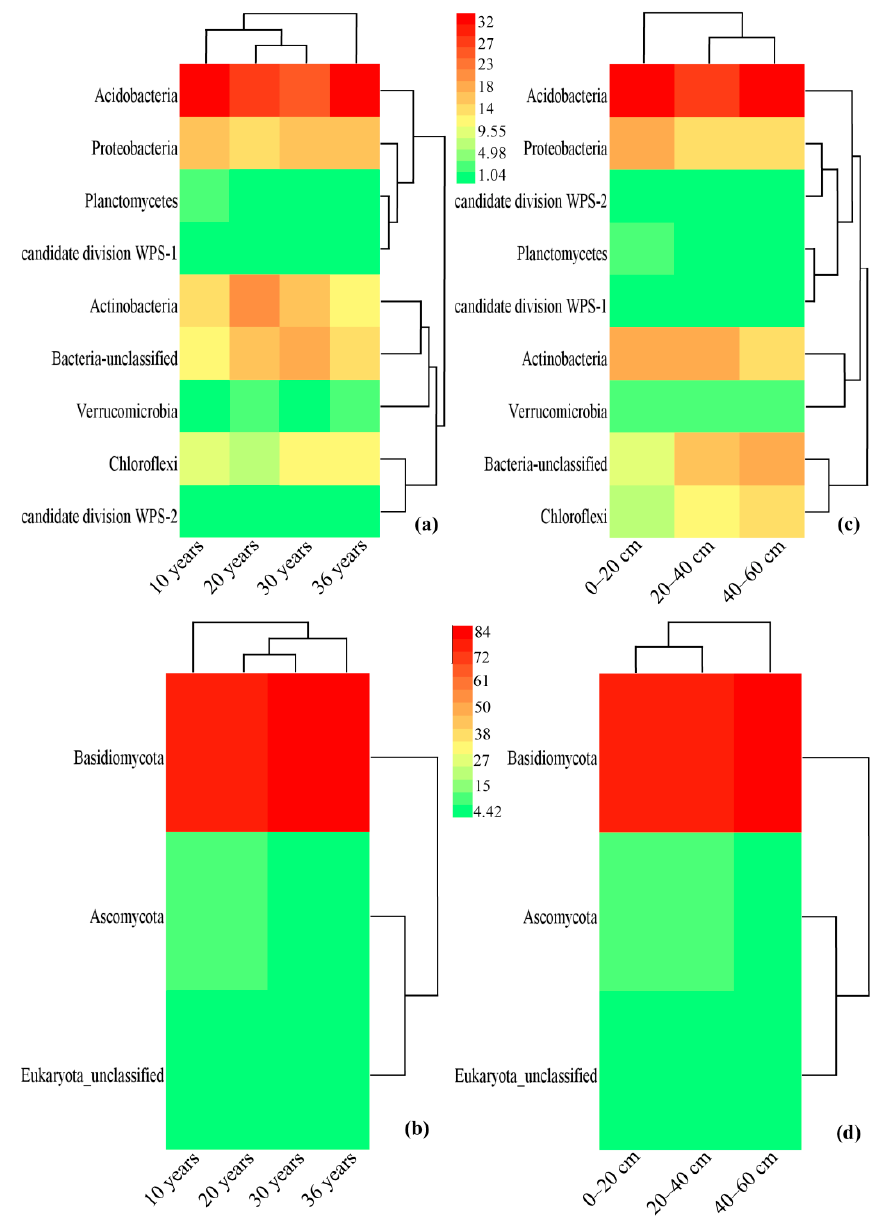
Figure 7. Heat map depicting the hierarchy cluster results for the abundance of bacteria and fungi at the phylum level. Phyla with more than 1% average abundance in at least one sample were considered as predominant. ( a , b ) show the clustering of bacteria and fungi at different ages, respectively. ( c , d ) show the clustering of bacteria and fungi at different soil depths, respectively. Red indicates high relative abundance and green indicates low relative abundance. 0–20 cm: 0–20 cm soil depth; 20–40 cm: 20–40 cm soil depth; 40–60 cm: 40–60 cm soil depth.